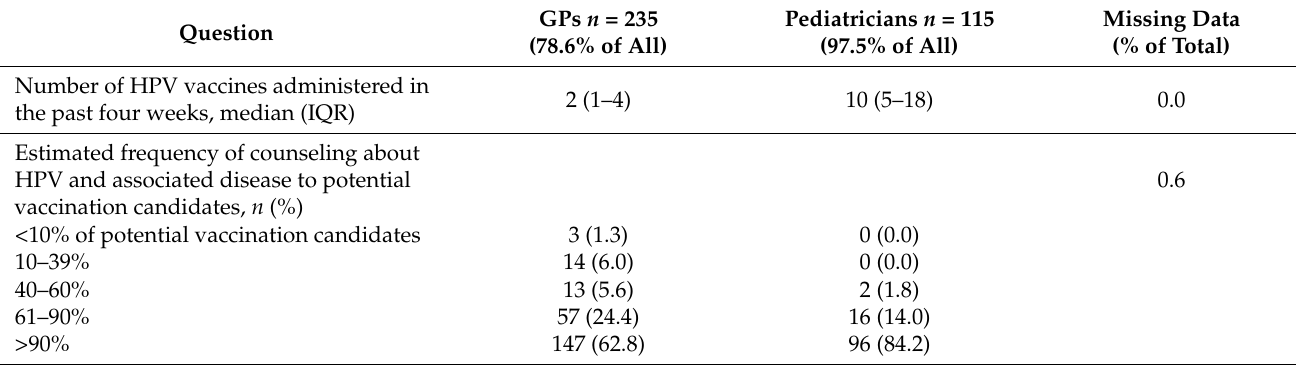
Table 2. Questions directed at study participants who indicated providing human papillomavirus (HPV) vaccination in